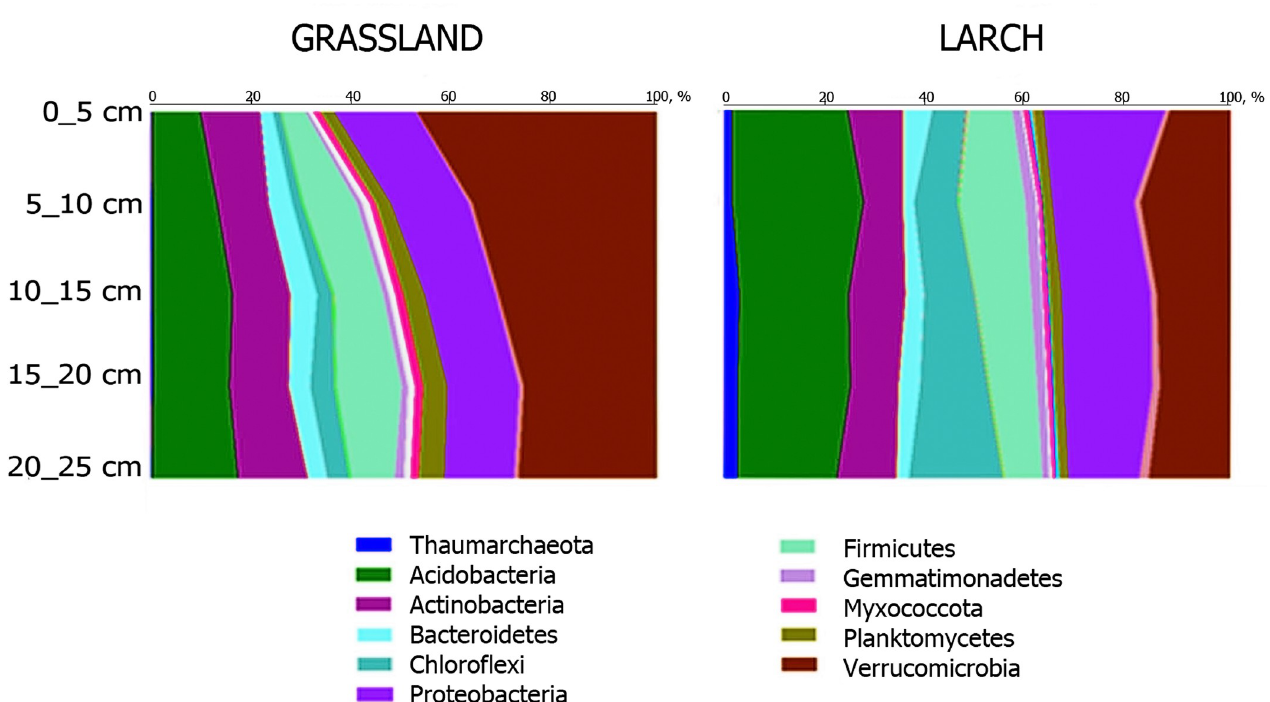
Fig 3. Taxonomic structure of soil microbiomes at the level of prokaryotic phyla � . � Only phyla with a share of more than 1% �� in the community are represented. �� The proportional values of dominating phyla in each soil sample are indicated in S3 Table.